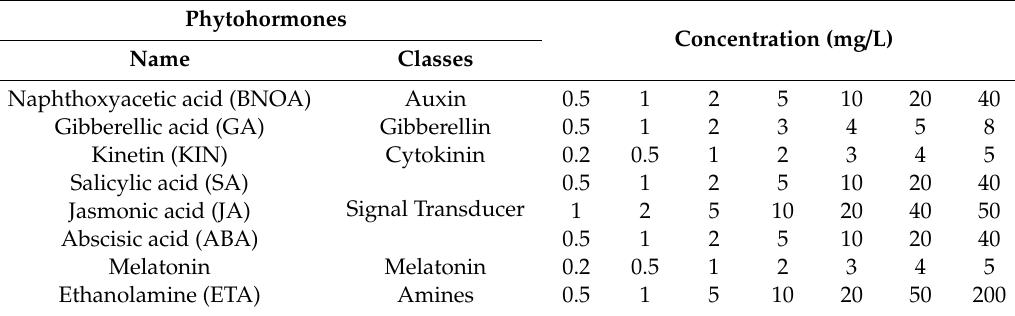
Table 1. List of phytohormones, classes and concentrations used in this